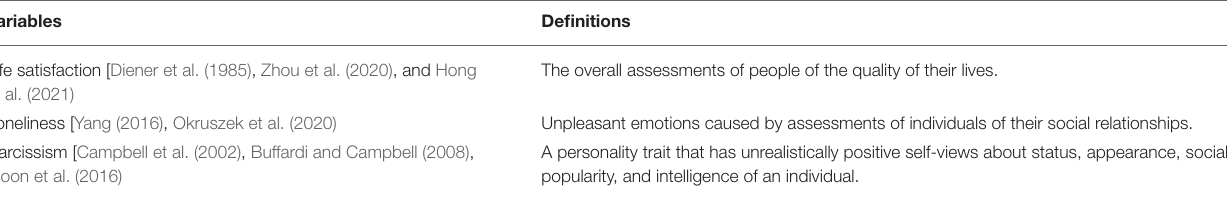
TABLE 1 | Definitions of life satisfaction, loneliness, and narcissism.